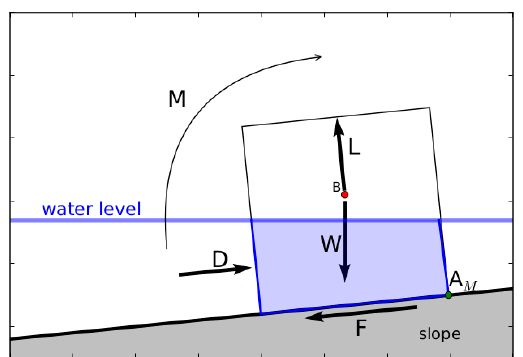
Figure 2. Sketch of forces and torques acting on a partially submerged block located on a slope of incline angle θ . Letters W , D , F, L denote weight, drag force, friction force, and lift force respectively. B is the center of mass and A M is the rotation axis. In computations, all forces are applied to the center of mass of the block B and all torques are computed with respect to the rotation axis passing through A M (after Bressan et al. [22]).